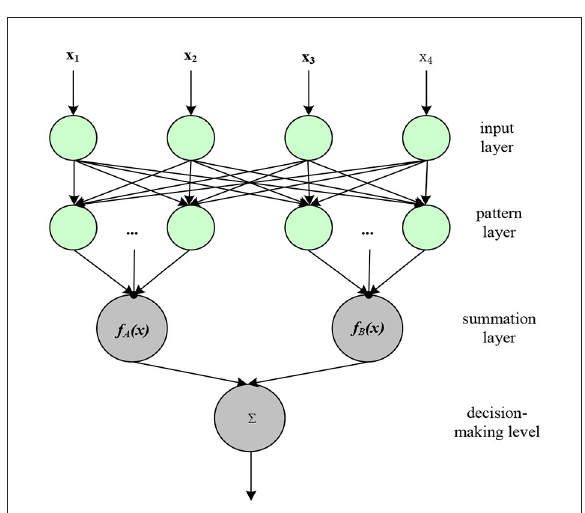
FIGURE5 Probability and statistics neural network structure diagram.